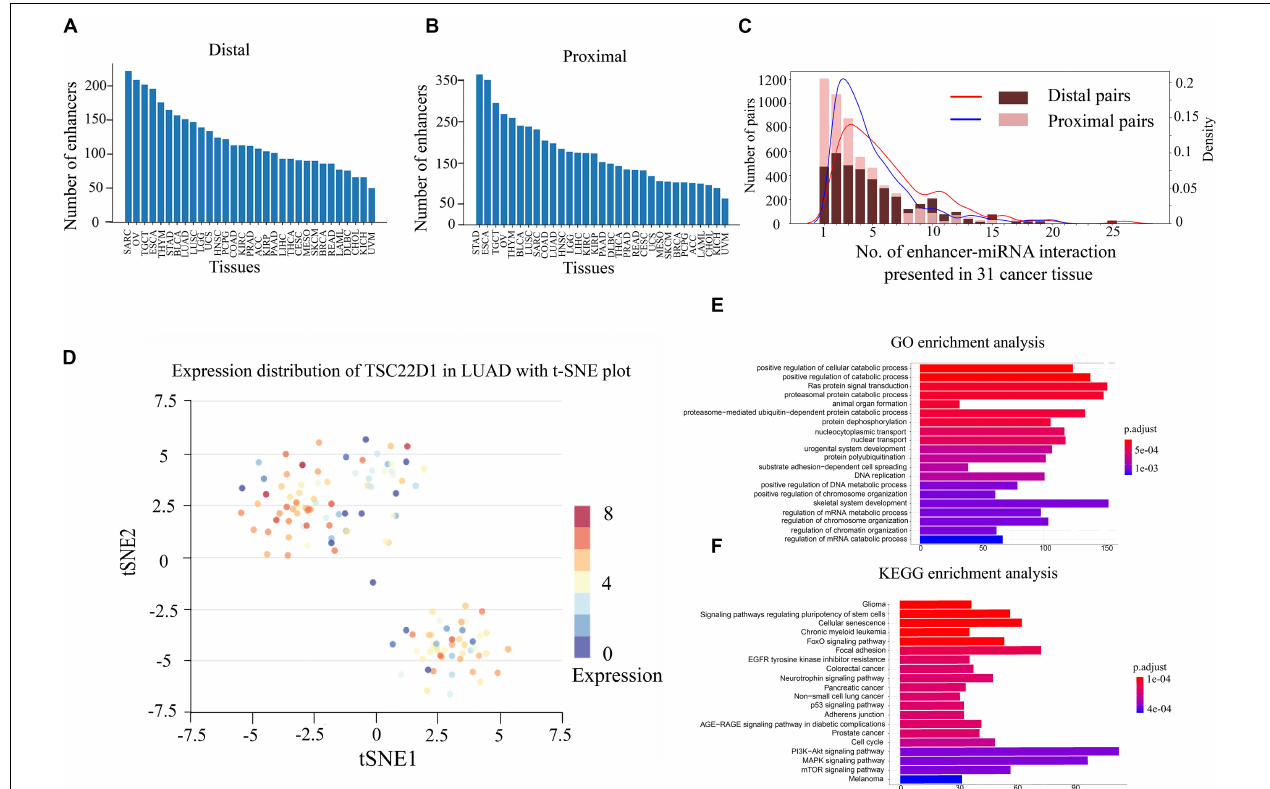
FIGURE 1 | Gene Ontology (GO) and Kyoto Encyclopedia of Genes and Genomes (KEGG) pathway enrichment analyses and single-cell RNA sequencing (scRNA-seq) analysis of enhancer–miRNA regulations. Number of pairs of proximal (A) or distal (B) regulations present in each cancer type. (C) Frequency of occurrence of enhancer–miRNA interactions appearing in 31 cancers. (D) scRNA-seq analysis of the expression of TSC22D1 in lung adenocarcinoma ( LUAD ) using t-SNE cluster. GO (E) and KEGG pathway (F) enrichment analyses of the target genes of miRNAs that are regulated by ubiquitously expressed